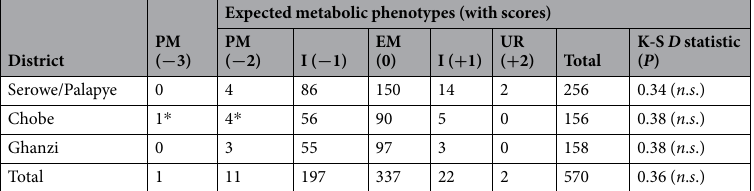
Table 5. Distribution of the inferred metabolic phenotype and scores by district, and Kolmogorv-Smirnov (K-S) D statistics with associated P values to test the normal distribution of data. Score attribution was made